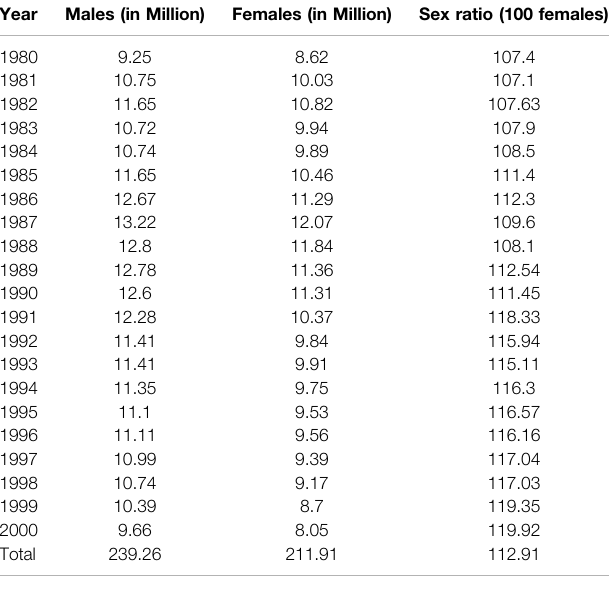
TABLE 1 | Children born between 1980 and 2000.